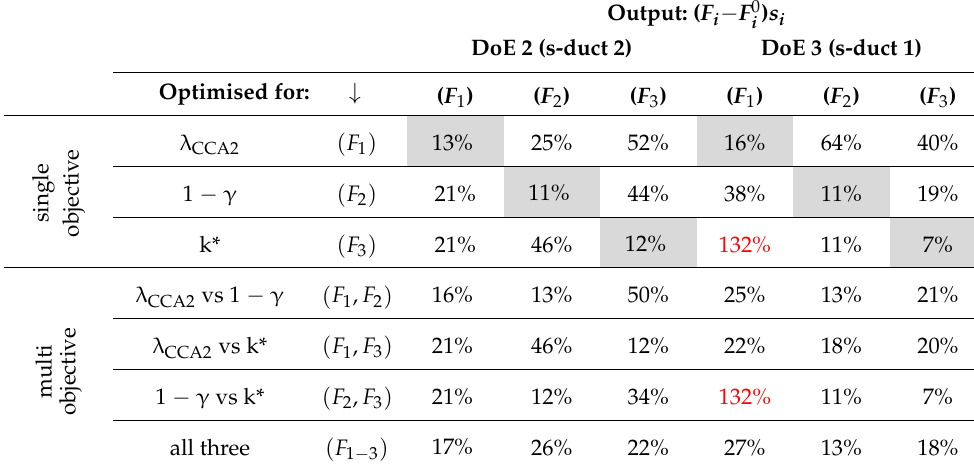
Table 7. Optimal design outputs of DoE 2 and DoE